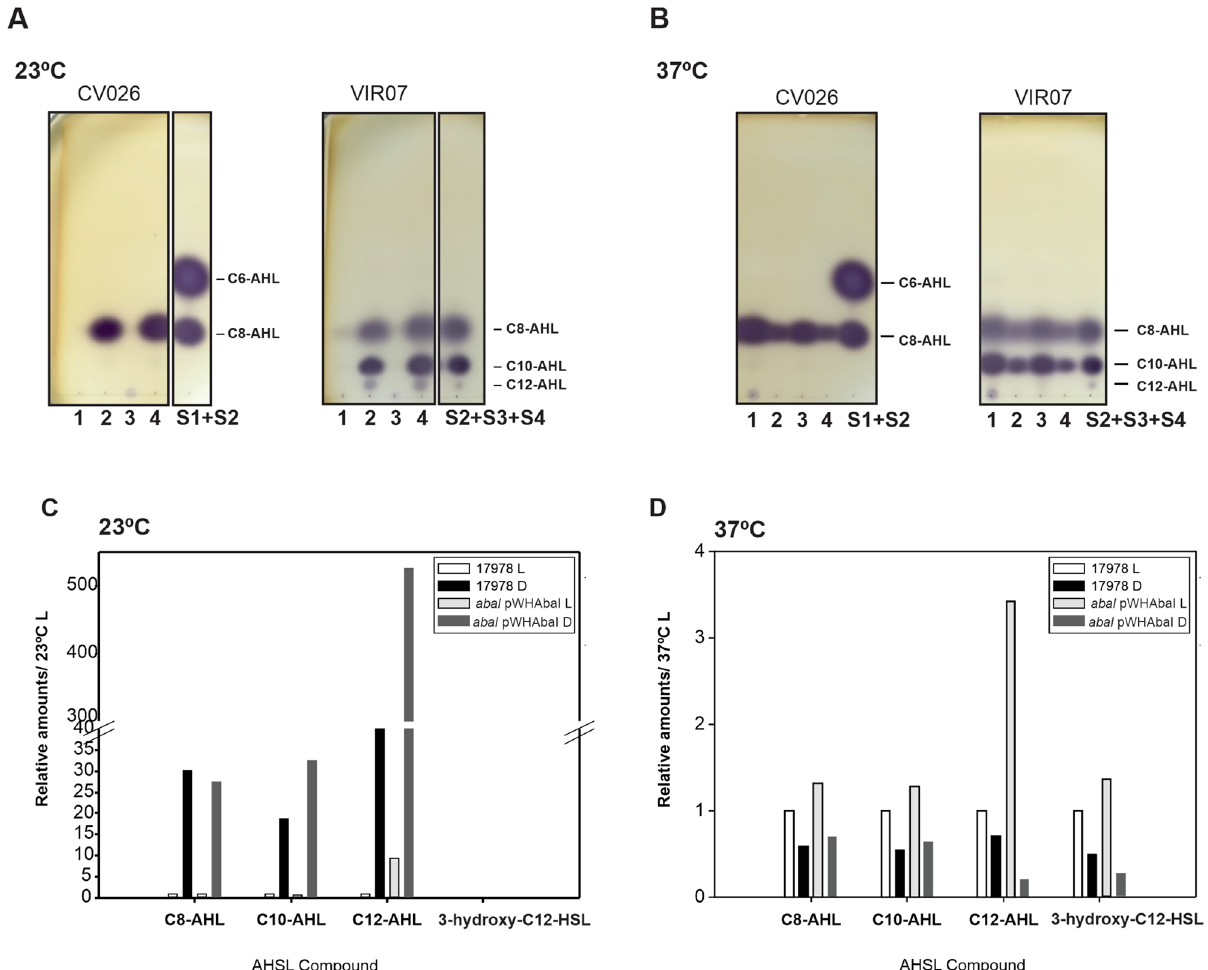
Figure 3. TLC and GC-mass spectrometry of acyl-HSLs extracted from A. baumannii biofilms. ( A , B ) AHLs extracts were chromatographed on C 18 reversed-phase TLC, developed with 60% methanol, and the spots were visualized with the C. subtsugae CV026 or C. violaceum VIR07 reporter strains. Samples correspond to AHLs extracts of A. baumannii ATCC 17978 biofilm cultures incubated at 23 °C ( A ) or 37 °C ( B ) under blue light (lane 1) and in the dark (lane 2); or the abaI mutant harboring pWHabaI under blue light (lane 3) and in the dark (lane 4). S1: C6-AHL, S2: C8-AHL, S3: C10-AHL and S4: C12-HSL. S2 + S3 + S4: a mixture of the S3, S4 and S5 standards. Results shown are representative of 2 independent experiments. ( C , D ) AHL extracts were dissolved in 100 µl HPLC-grade acetonitrile and silylated in a nitrogen atmosphere (1 h at 80 °C). One μl of derivatized sample was injected (Split 1:10) into the GC-mass spectrometer. For each condition (23 or 37 °C), quantitation ion’s areas of each AHL were relativized to the one obtained in the 17978 sample incubated under blue light condition. Results shown are representative of 2 independent in a C. subtsugae CV026 - inoculated LB plate. The extent of inhibition of violacein production compared to the control provides an indication of quorum quenching activity. As shown before, the addition of 2 µg of commercial C8-AHL to the central well of C. subtsugae CV026- inoculated LB plates stimulated the production of violacein in the whole plate (Fig. 2A). Interestingly, when this fixed amount of standard was mixed with the supernatant of the sonicated wild type cells from motility plates under blue light, violacein production was less produced than when they were incubated in the dark (Fig. 2A). In contrast, when the standard was incubated with supernatants from sonicated ΔblsA mutant cells incubated either under blue light or in the dark, similar capability to inhibit violacein production was observed, which was similar to that of the wild type incubated in the dark, showing thus loss of photoregulation of quorum quenching activity (Fig. 2A). Finally, when supernatants from sonicated ΔabaI cells recovered from motility plates under blue light at 23 °C were used, no violacein production was observed indicating that the standard was completely degraded (Fig. 2A). On the contrary, when the standard was incubated with supernatants of sonicated ΔabaI pWH abaI cells from motility plates incubated in the dark at 23 °, C. subtsugae CV026 produced an important violacein halo comparable to that of the wild type in the dark (Fig. 2A). These results thus indicate much higher quorum quenching activity under blue light than in the dark in this strain, much higher even than in the wild type strain (Fig. 2A).